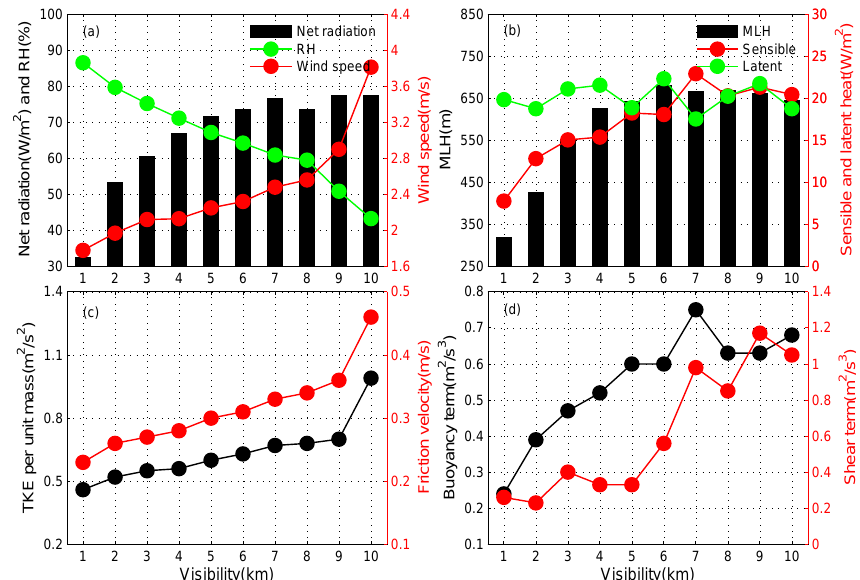
Figure 11. Variations in net radiation, RH, and wind speed (a) , MLH, sensible and latent heat (b) , TKE per unit mass, and friction velocity (c) , and buoyancy and shear term in TKE (d) according to visibility.